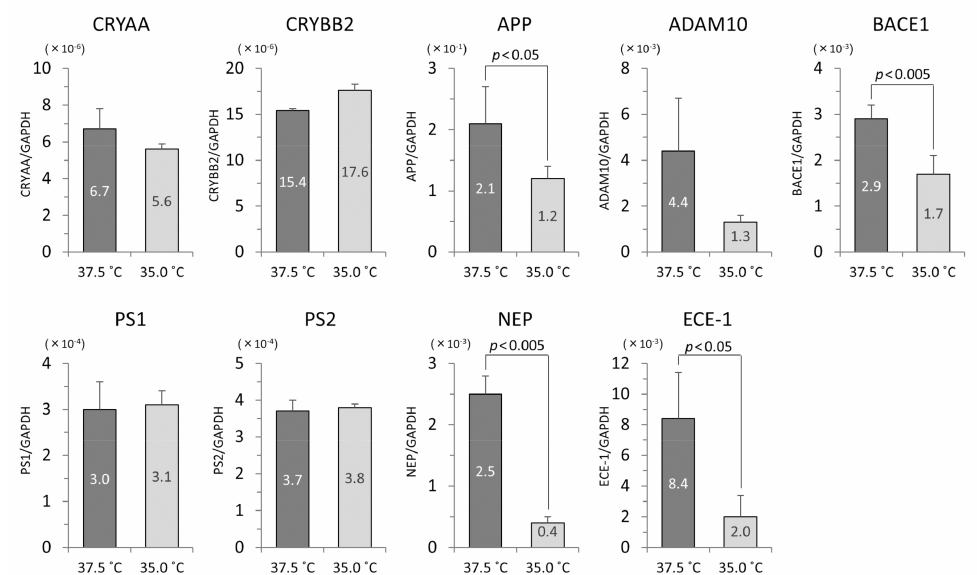
Figure 6. The qPCR results related to lens protein and A β protein in iHLEC-NY2 cells. The vertical axis is the mRNA value of the target gene-corrected by glyceraldehyde-3-phosphate dehydrogenase